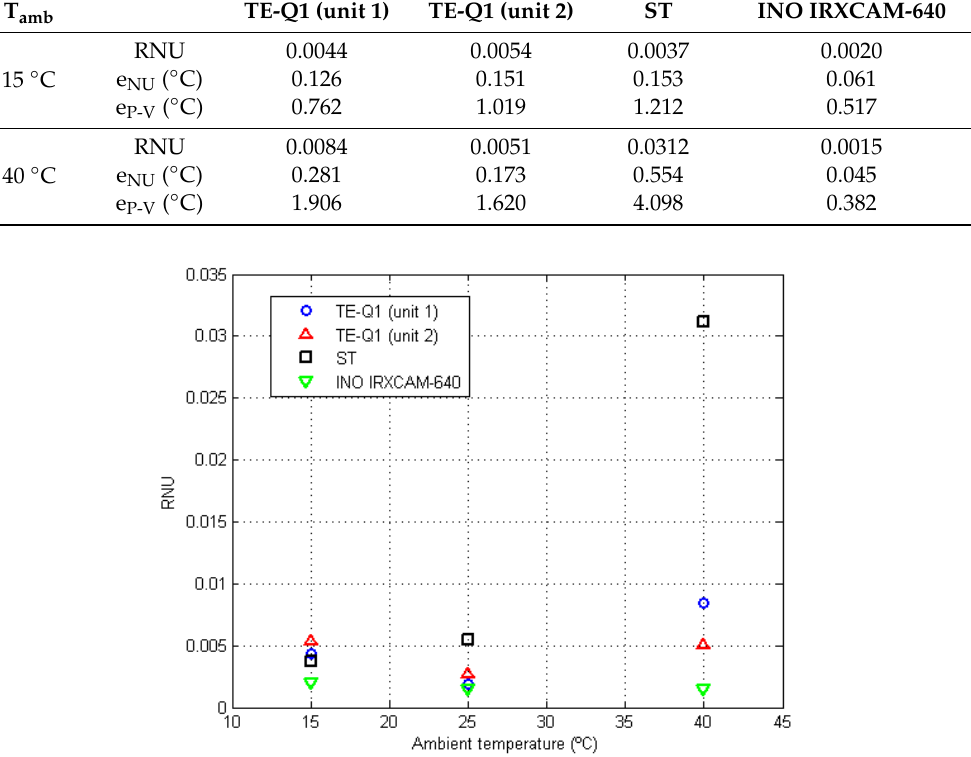
Figure 5. RNU values at different room temperatures (15 °C, 25 °C, and 40 °C) for the tested cameras. The symbols are color-coded, as indicated in the legend, depending on the employed camera: TE-Q1 (unit 1) blue circles, TE-Q1 (unit 2) red triangles, ST black squares, and INO IRXCAM-640 green inverted triangles.